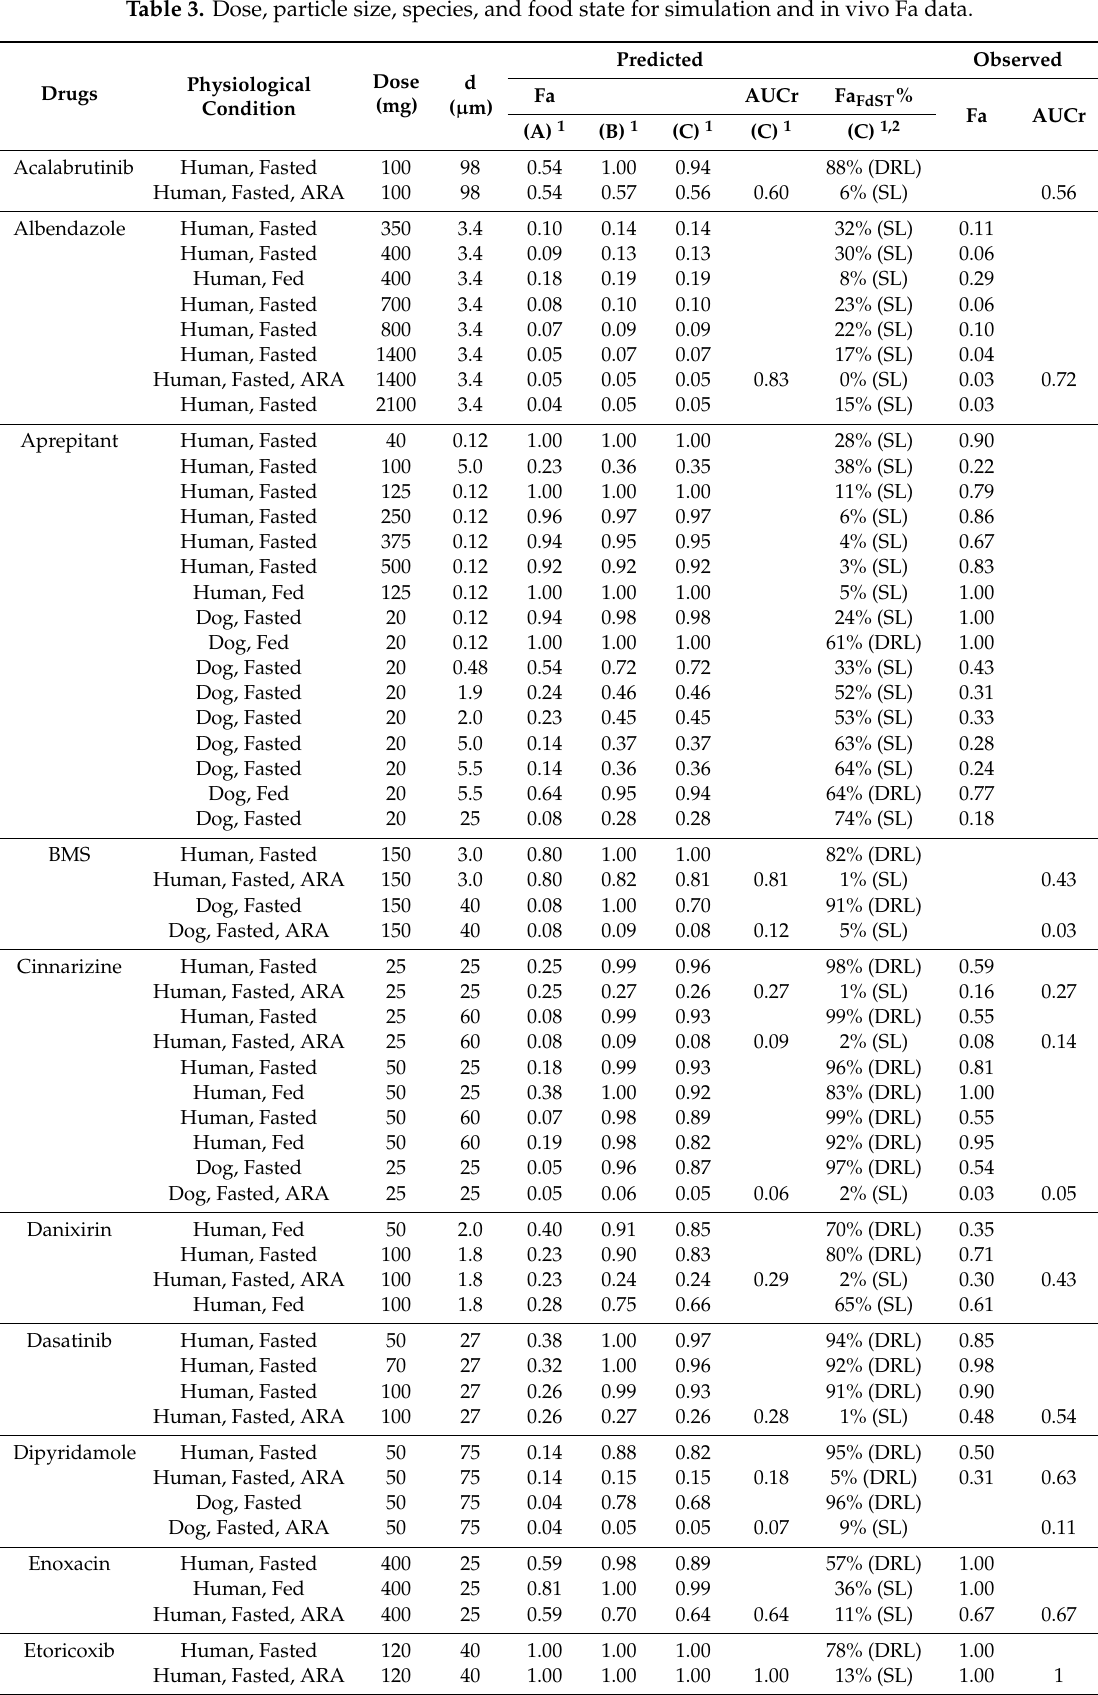
Table 3. Dose, particle size, species, and food state for simulation and in vivo Fa